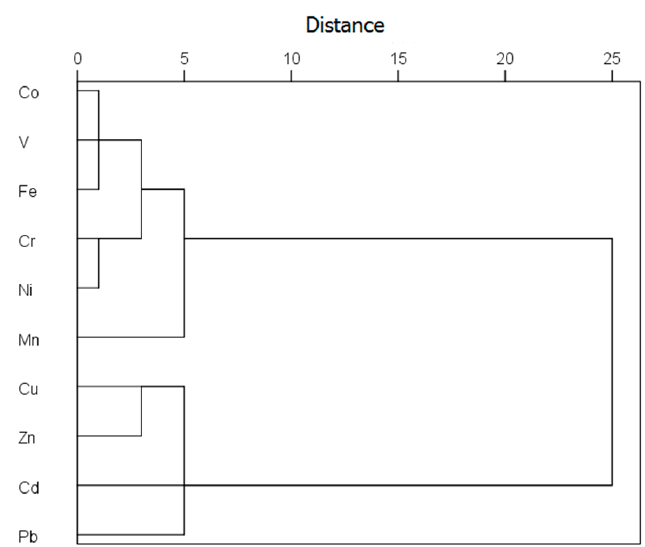
Figure 3. Hierarchical dendrogram for heavy metals in the 43 settled dust samples obtained by Ward’s hierarchical clustering method.